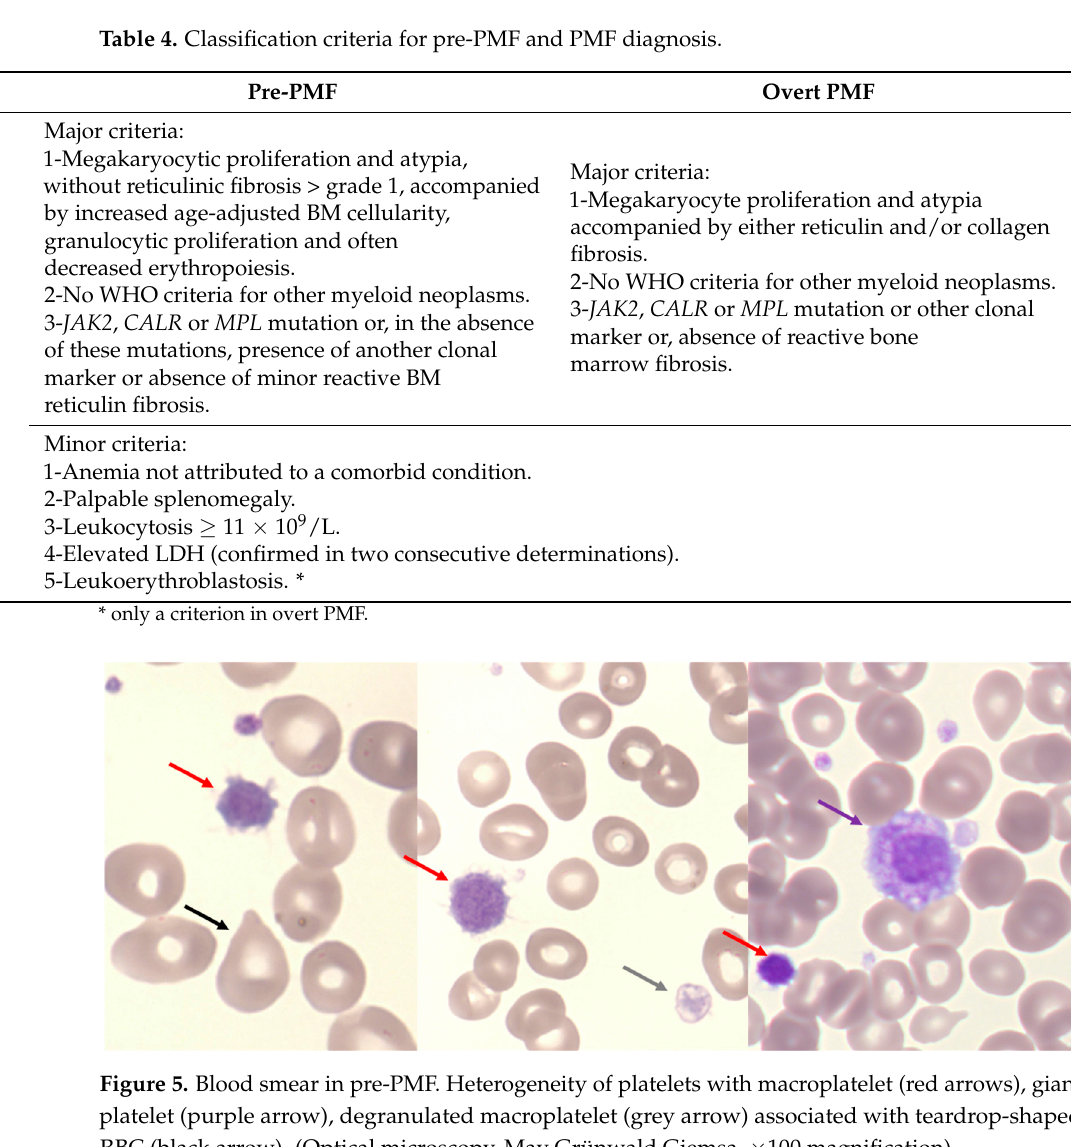
Figure 6. Morphological aspect of megakaryocytes in BM pre-PMF. ( a ) Atypical megakaryocytes with variable size (large to small) in pre-PMF: with hyperchromatic nuclei; ( b – d ) Enlarged megakar- yocytes with variable lobulation; ( e , f ) Sca tt ered small megakaryocytes with nude nuclei in platelet clusters. (Optical microscopy, May Grünwald Giemsa, ×100 magni fi cation).